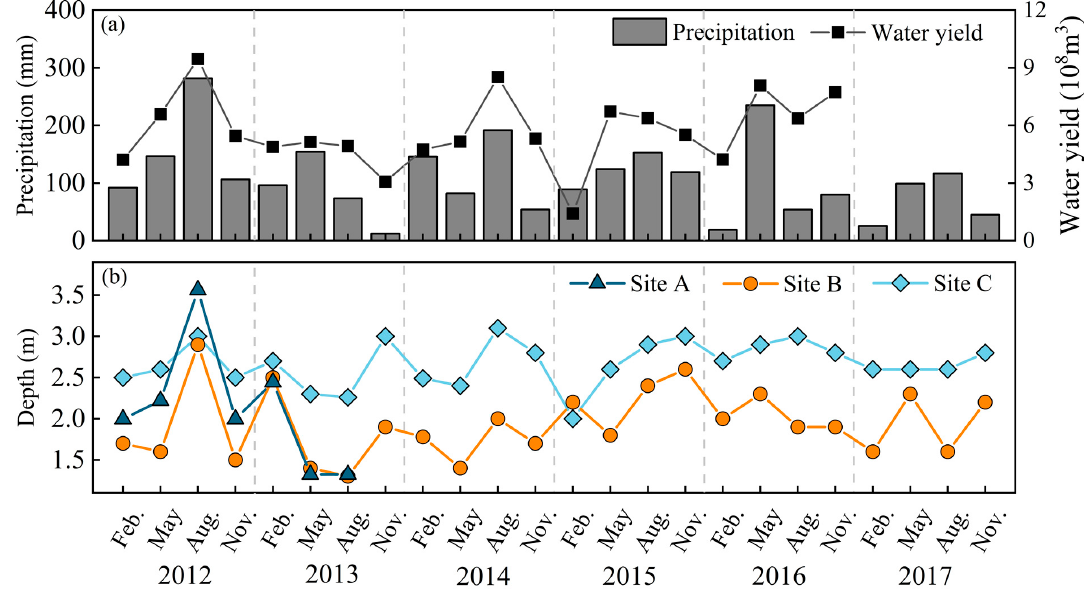
Figure 2. Seasonal variations of precipitation and inflowing water yield ( a ) of Lake Taihu and ( b ) the variation in water depth at site A, B, and C during the sampling period.